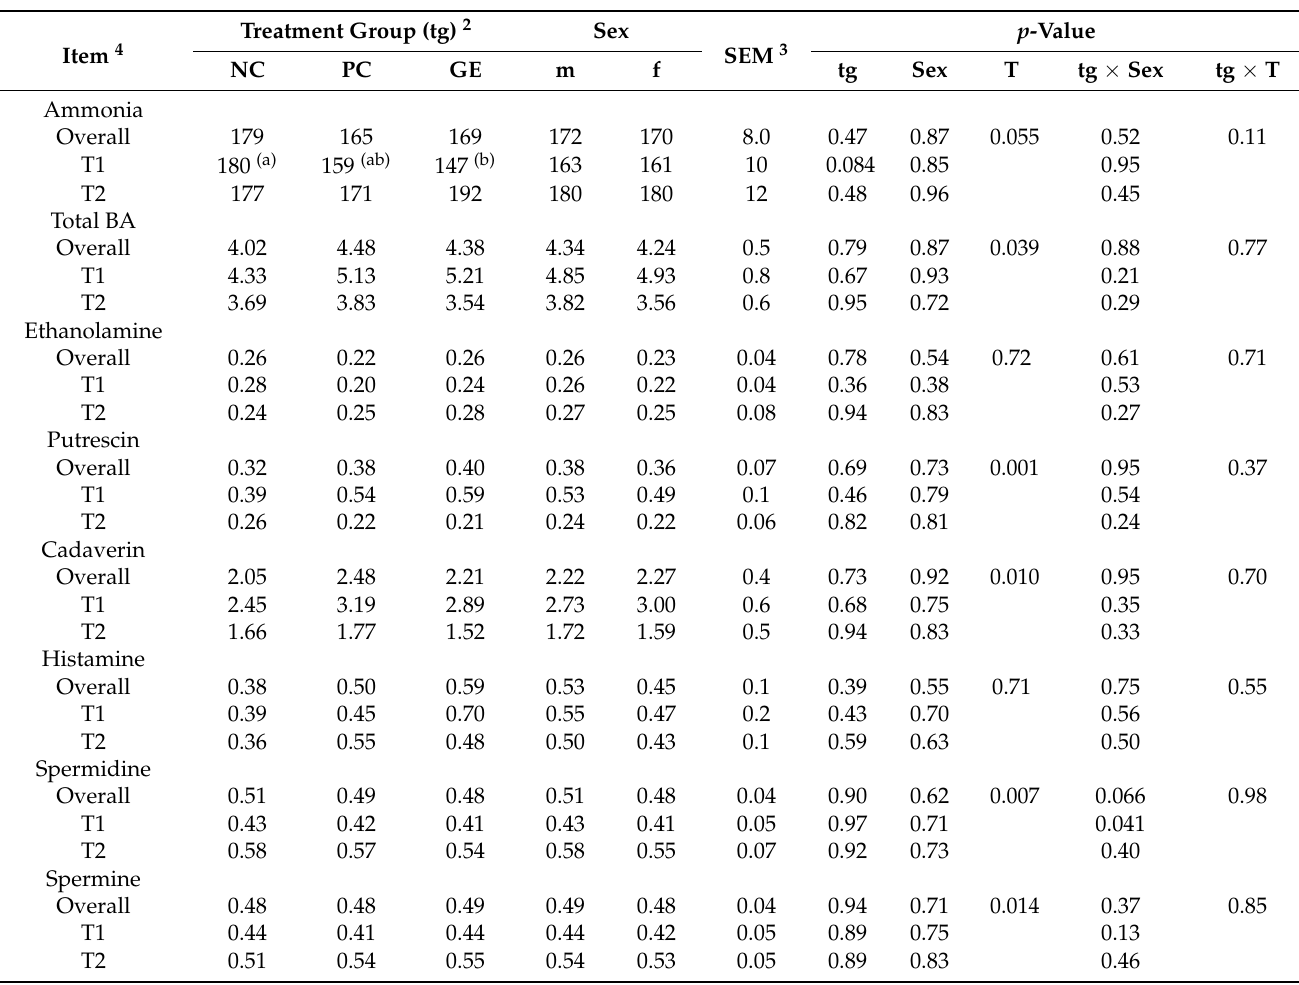
Table 7. Effect of using NC and PC for testing dietary GE supplementation on the concentrations of ammonia ( µ g/g) and biogenic amines (BA) (mmol/kg) in ileal content of weaning piglets in two different sampling points 1 .